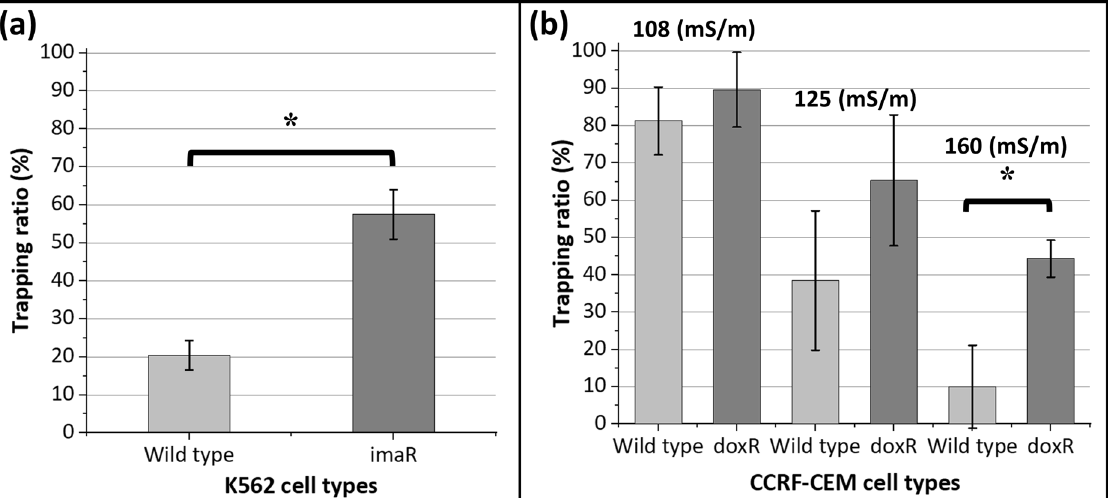
Figure 4. Dielectrophoretic behavior of leukemia cells and their drug resistant progenies. ( a ) The trapping ratio of K562/wt and K562/imaR cells immersed in relatively HCB (σ = 200mS/m) at 8.6 MHz under 20V pp and at a flow rate of 1 µL/min. ( b ) The trapping ratio of CCRF-CEM/wt and CCRF-CEM/doxR cells in different buffers, with 110, 125, and 160 mS/m conductivity, at 6.2 MHz under 20V pp and at a flow rate of 1 µL/min. Results are presented as mean ± stdev. * indicates significantly different results at the p = 0.05 level (n =